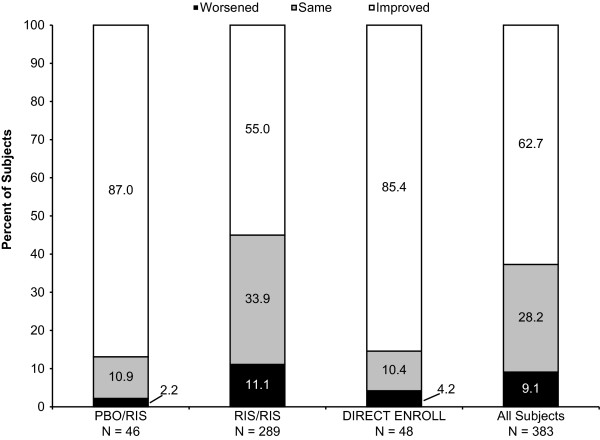
Percentage of subjects with improved, the same, or worsened clinical status at the 6-month end point, by Clinical Global Impressions of Severity ratings. Intent-to-treat population, last observation carried forward